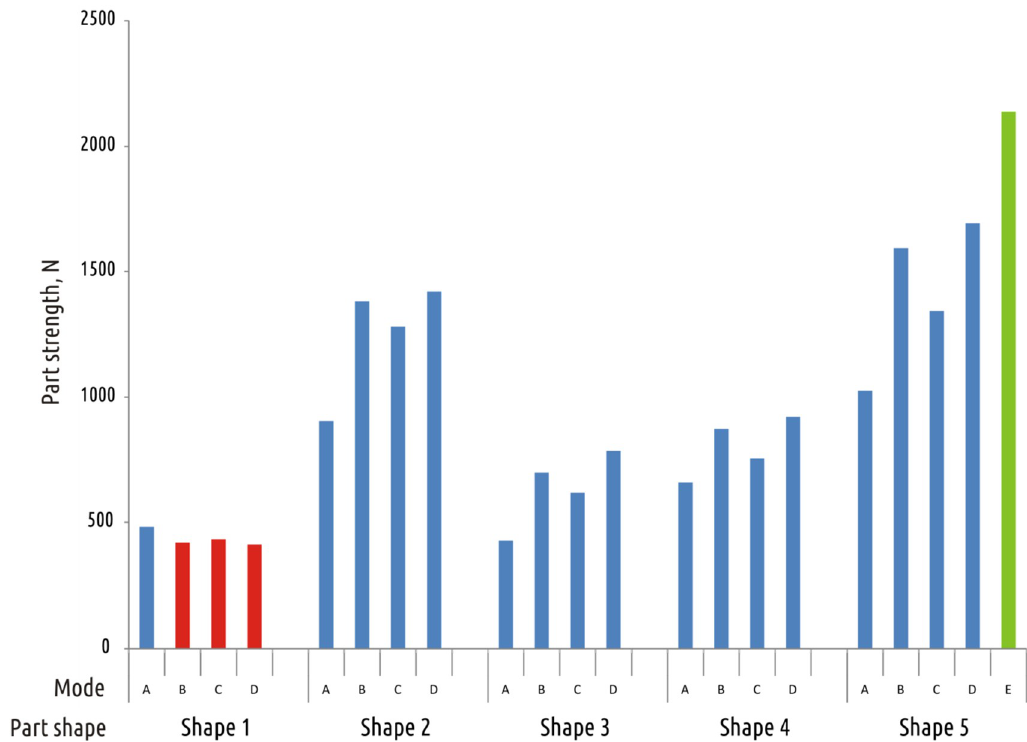
Figure 15. Summary on part strength achieved by different printing modes on all tested shapes.